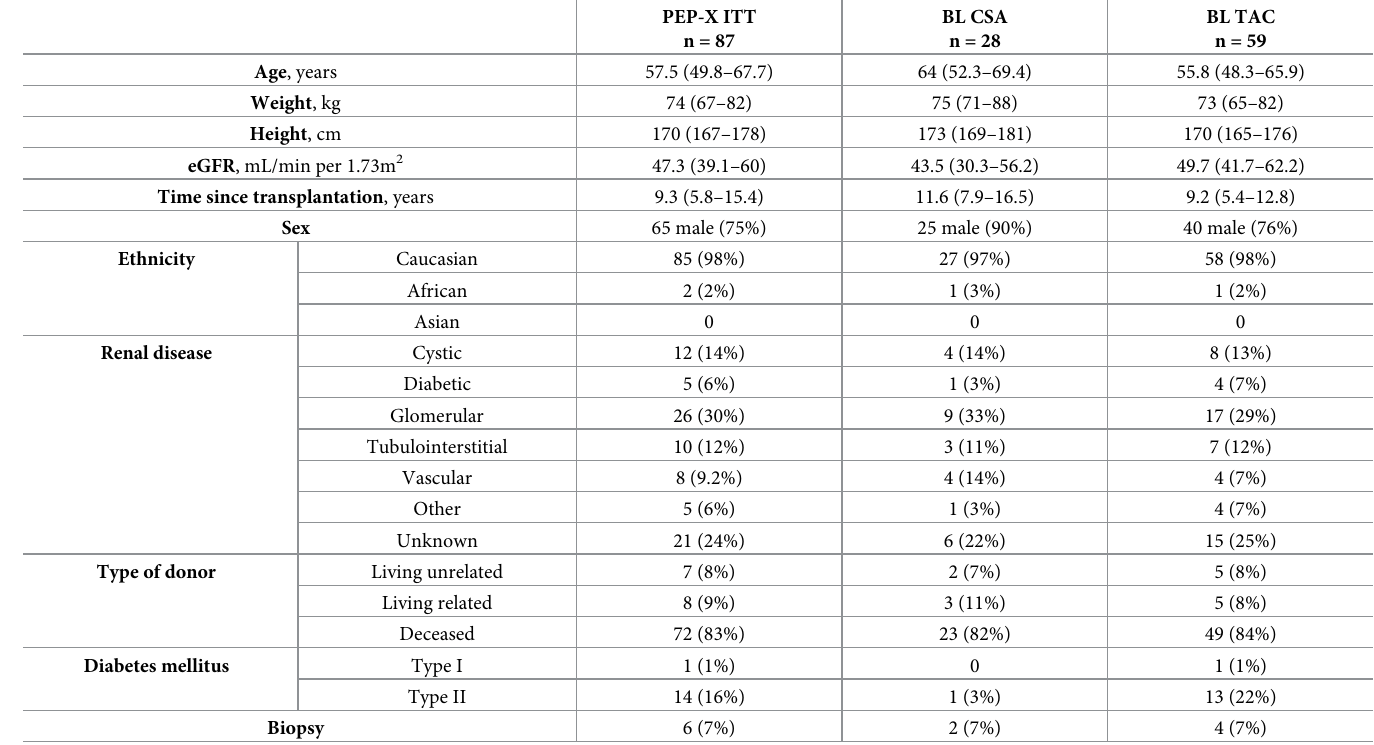
Table 1. Patient characteristics of 87 kidney transplant recipients converted from either ciclosporin or tacrolimus to modified release tacrolimus.